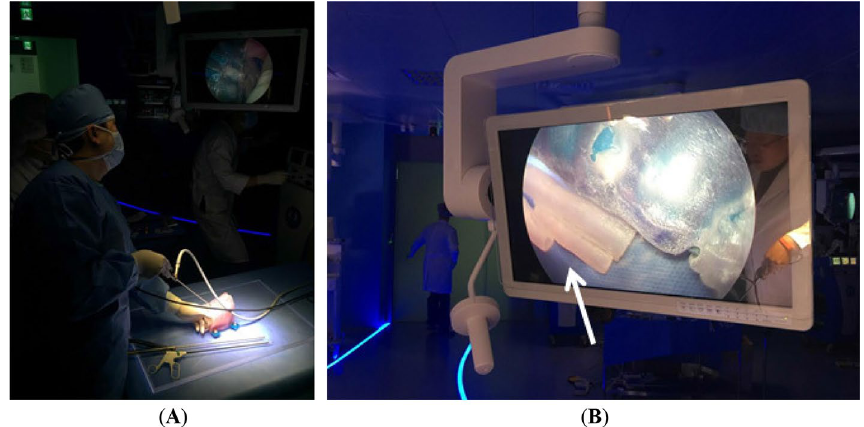
Figure 7. VATS simulation with esophageal atresia with a tracheoesophageal fistula using 3D-printed phantom: ( A ) a surgeon’s simulation of the 3D-printed phantom and ( B ) viewing the video screen (thick white arrow to indicate esophageal atresia with a tracheoesophageal